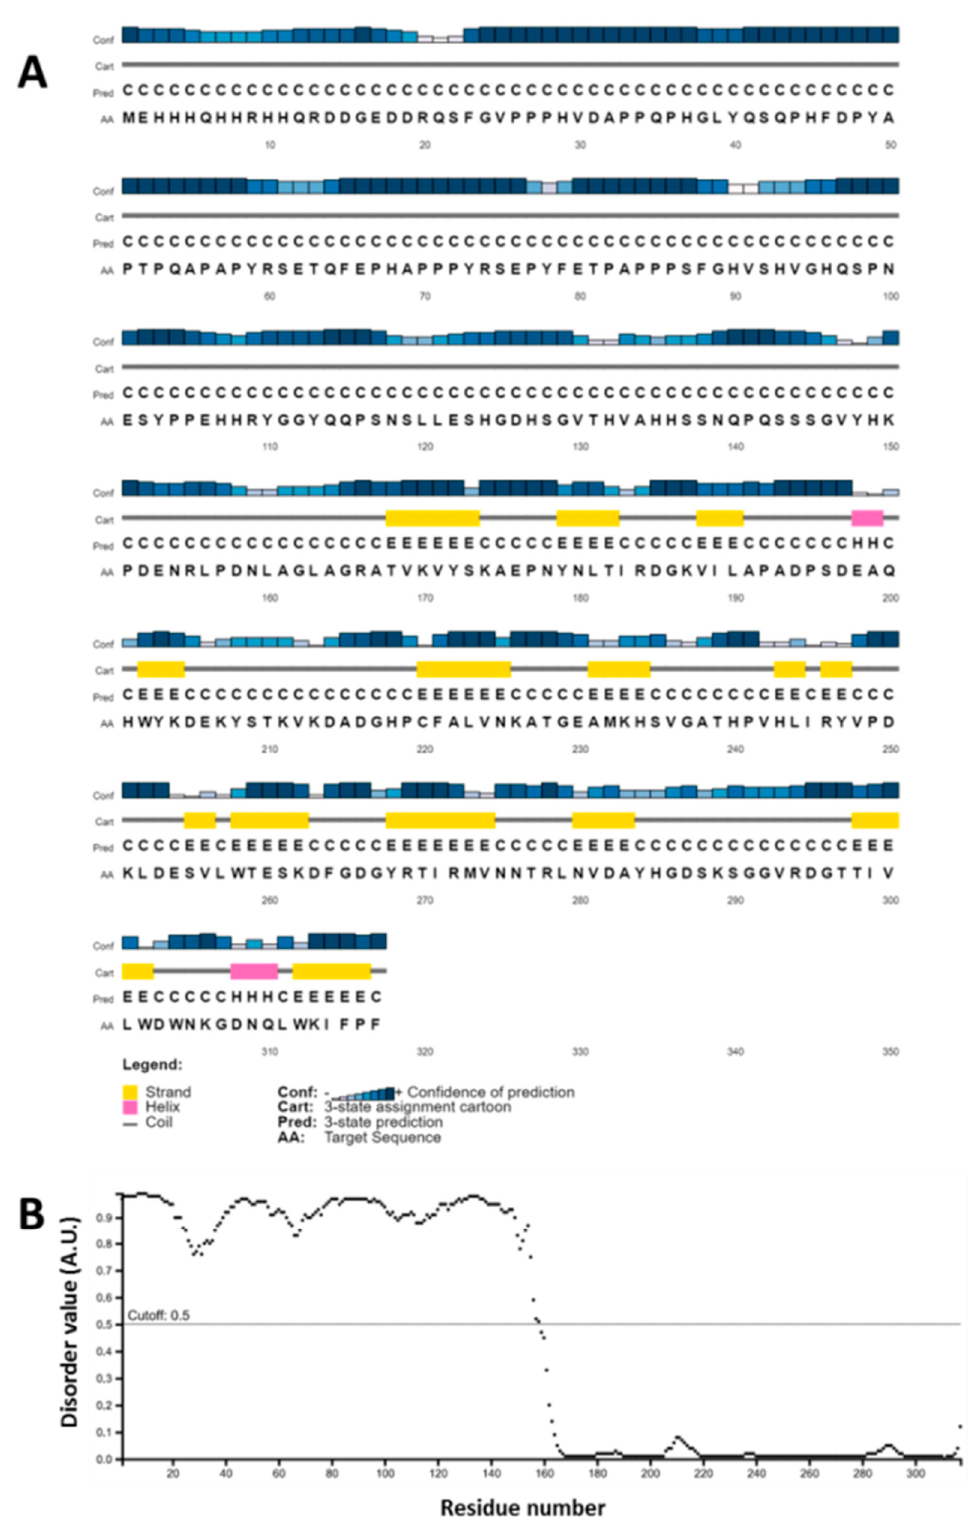
Figure 5. Amino acid sequence analysis of ArathEULS3. ( A ) Secondary structure prediction by PsiPred 4.0. The colors represent protein secondary structure elements (yellow for β -strands, pink for α helix and grey for coil structures). ( B ) Disorder plot by DISOPRED3.